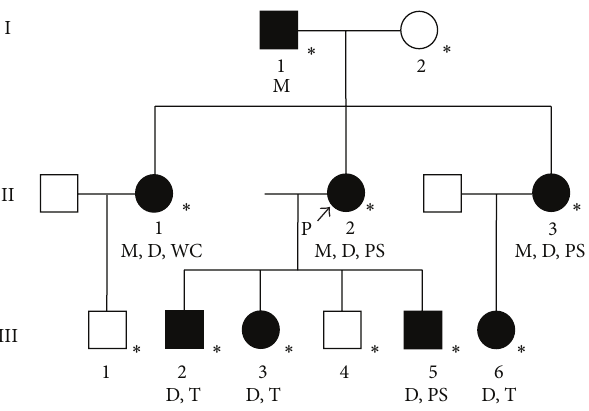
Figure 1: Pedigree structure of the family. I-1 (74 years) had mild myoclonus in his neck induced by psychiatric stress. II-1 (45 years) had cervical dystonia, writer’s cramp, and mild myoclonus in her upper limb, neck, and voice. Alcohol intake does not improve her symptoms, according to interview. II-2 (42 years) is the proband of this family and has an 𝜀 -sarcoglycan gene mutation causing DYT11. Details are described in the text. II-3 (40 years) had cervical dystonia, mild action myoclonus in her right hand, and psychiatric symptoms, which were diagnosed as schizophrenia by psychiatrists. She often feels fear. In III-2 (21 years) and III-3 (13 years),